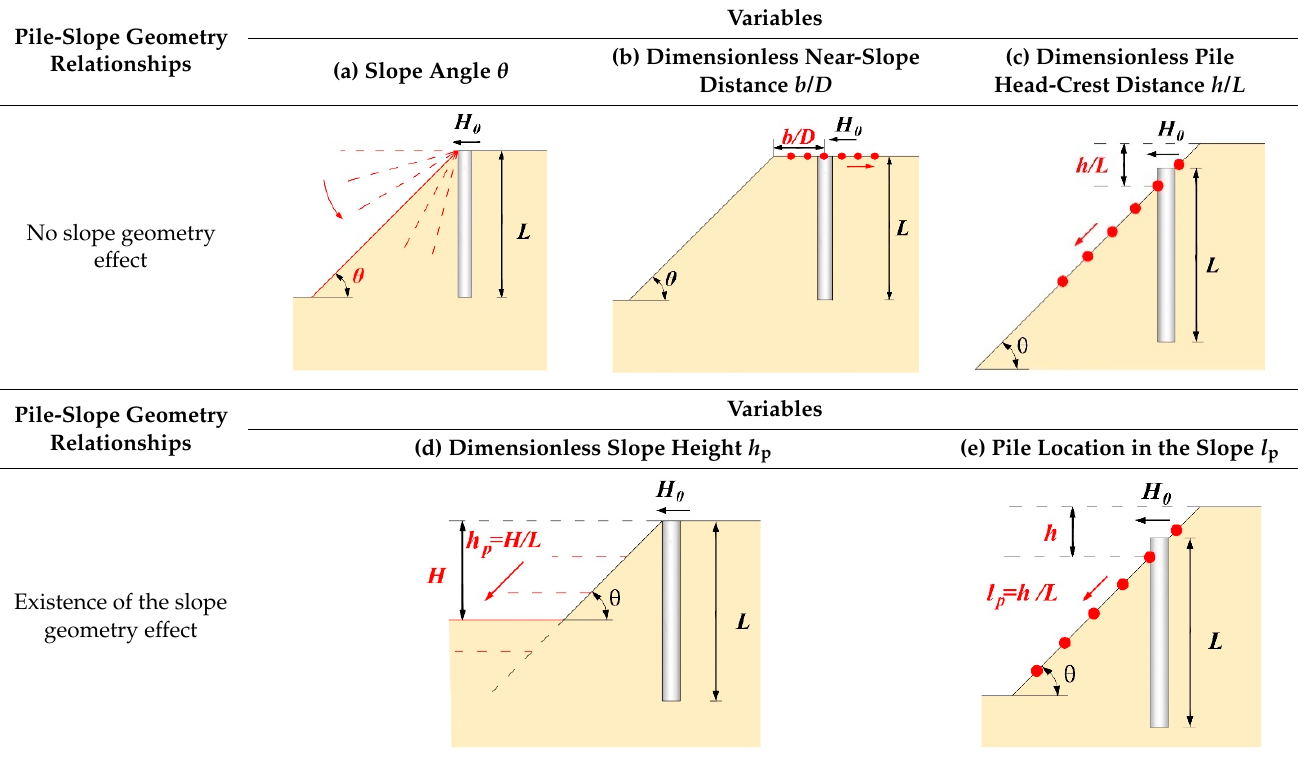
Table 1. Pile-slope geometry relationships. Table 1. Pile–slope geometry relationships. Table 1. Pile–slope geometry relationships. Table 1. Pile–slope geometry relationships. Table 1. Pile–slope geometry relationships. Table 1. Pile–slope geometry